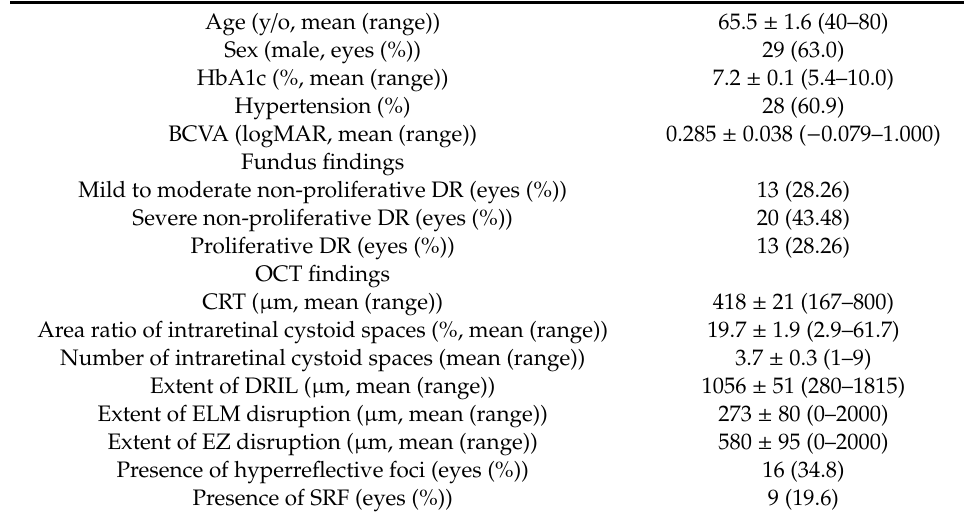
Table 1. Baseline characteristics.